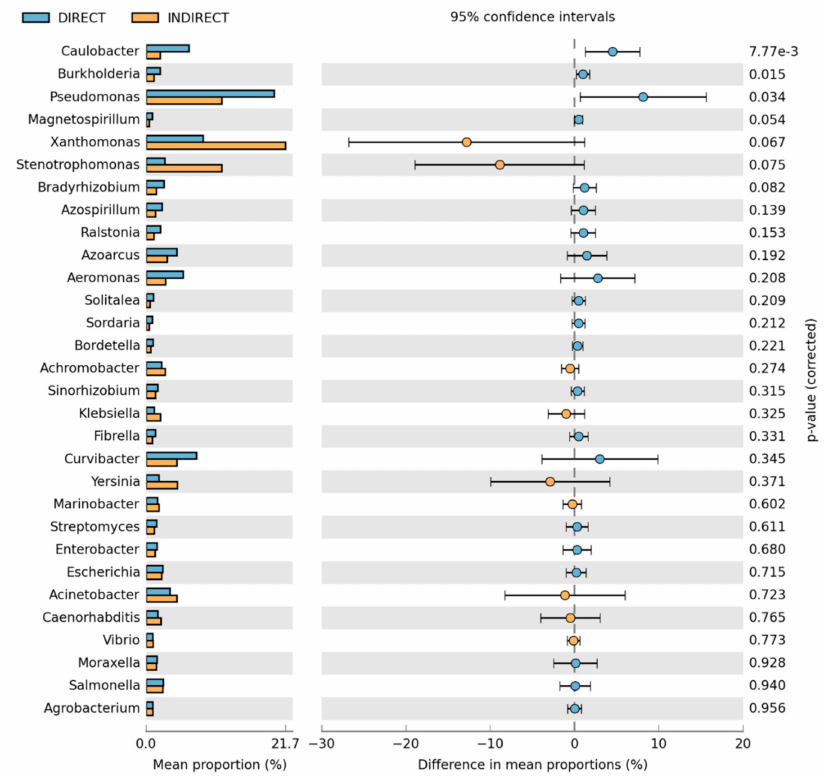
Figure 5. Differential abundance profile (genus level) between direct and indirect source biofilm samples on the basis of Fischer’s exact t -test with Storey’s FDR correction at 95% confidence interval. The bacterial abundance profile at genus level also depends on the piping material (galvanized iron vs. polyvinyl chloride) (Figure 6). Pseudomonas was the most common bacterial genus in biofilms grown in PVC pipes while Xanthomonas was most abundant in GI pipes. However, significant differences were only found in Vibrio ( p -value = 0.017), Azospirillum ( p -value = 0.021), Marinobacter ( p -value = 0.024), Moraxella ( p -value = 0.027) and Klebsiella ( p -value = 0.045) with all these genera being significantly abundant in GI rather than PVC piper